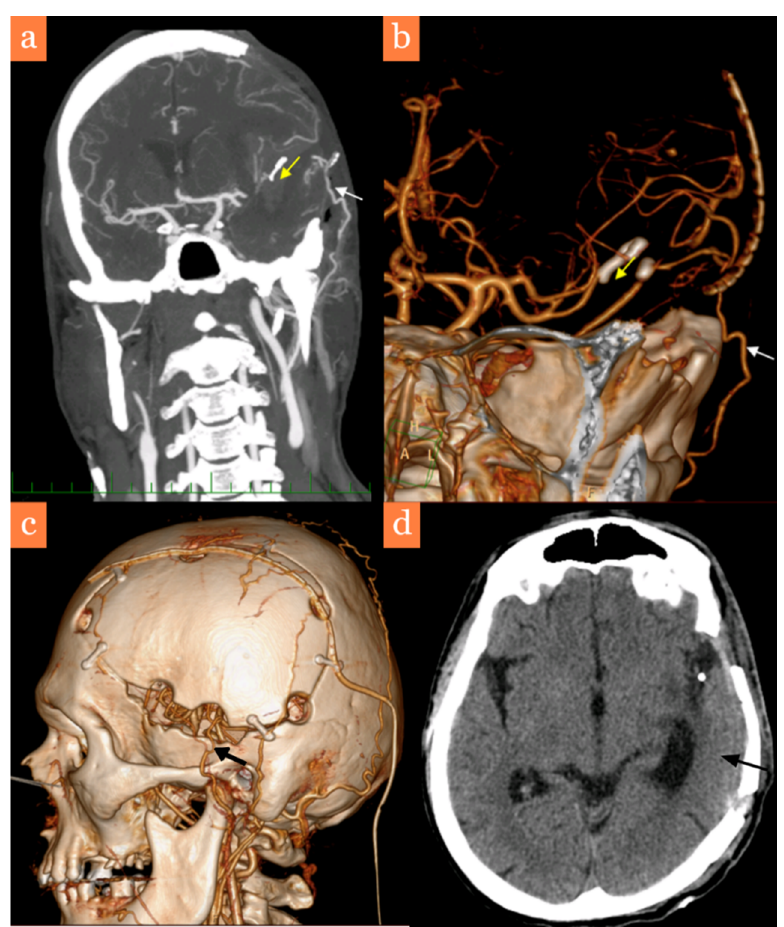
Figure 3. Graphic visualization after the second surgery. ( a , b ) CTA on the first postoperative day showing the trapped pseudoaneurysm (yellow arrow) and the EC-IC bypass (white arrow), ( c ) 3D side view after cranioplasty with an autologous bone flap with a CTA demonstrating the patent EC-IC bypass (black arrow), ( d ) CT after cranioplasty showing resorption of the remaining intracerebral hematoma and the ischemia-free temporal lobe (black arrow).